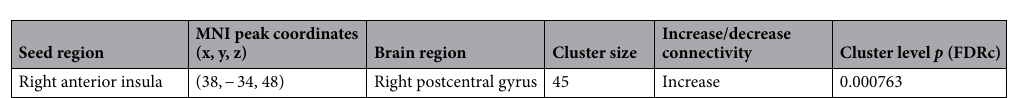
Table 5. Regressions predicting first onset of internalizing disorders adjusting for baseline internalizing symptoms. MNI Montreal Neurological Institute, FDR false discovery rate.